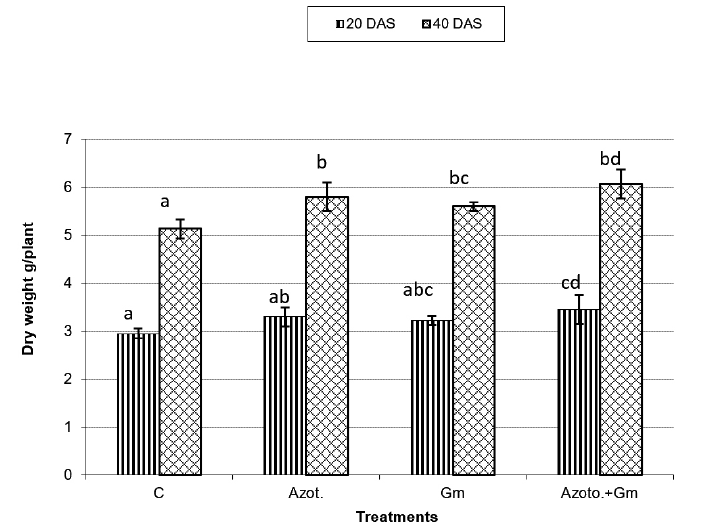
Fig. 1. Dry weight of onion plants as influenced by inoculation with Glomus moseae (Gm) and Azotobacter chroococcum (Azoto.), 20 and 40 days after planting Table 3. Population of Azotobacter and nitrogenase activity in onion rhizosphere as influenced by inoculation with